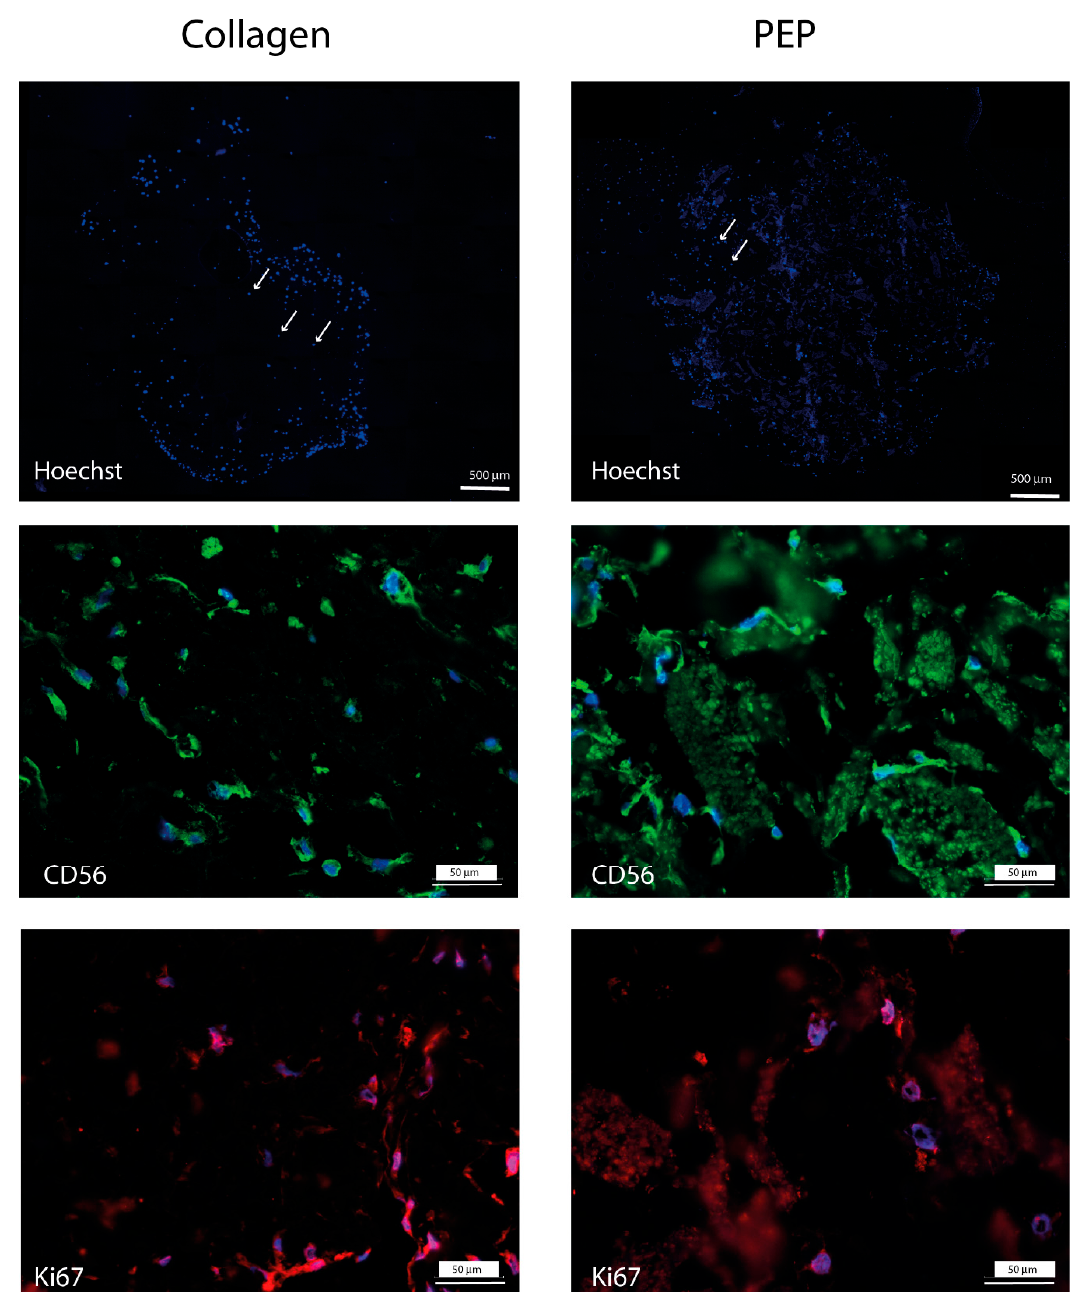
Figure 3. Scaffold with collagen (left panel) and with PEP (right panel) stimulate the growth of fibroblasts. Fibroblasts cells were cultured for one week, and further examined by immunohistochemistry. Expression of fibroblast marker TE7 (light green), proliferation marker KI67 (red), and fibroblast differentiation marker SMA (red). Cell nucleus outlined by Hoechst-staining (blue).